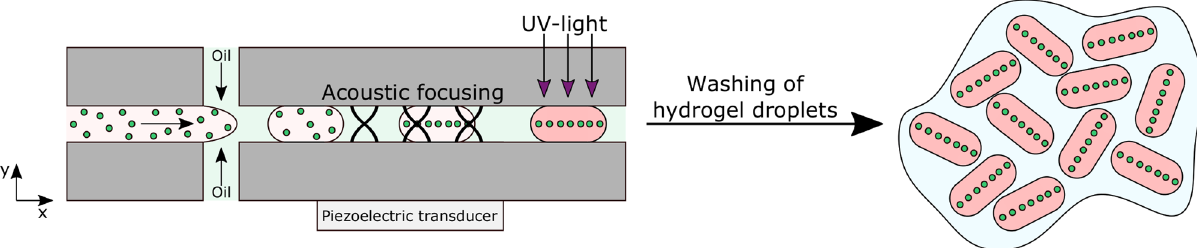
Figure 1. Droplets composed of hydrogel precursor solution (PEG or a combination of PEG and GelMA), photoinitiator and particles (beads or cells) are generated. The encapsulated particles are focused along the centre line of the droplets by the primary acoustic radiation force and cross-linked by exposure to UV-light. The hydrogel droplets are collected and washed to remove the oil and surfactant.